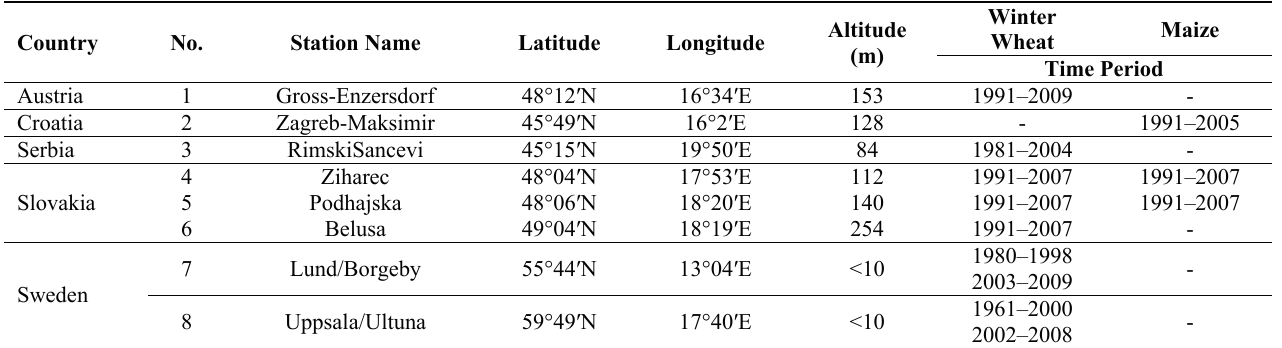
Table 1. List of countries, stations, and time periods of weather data used in the study.